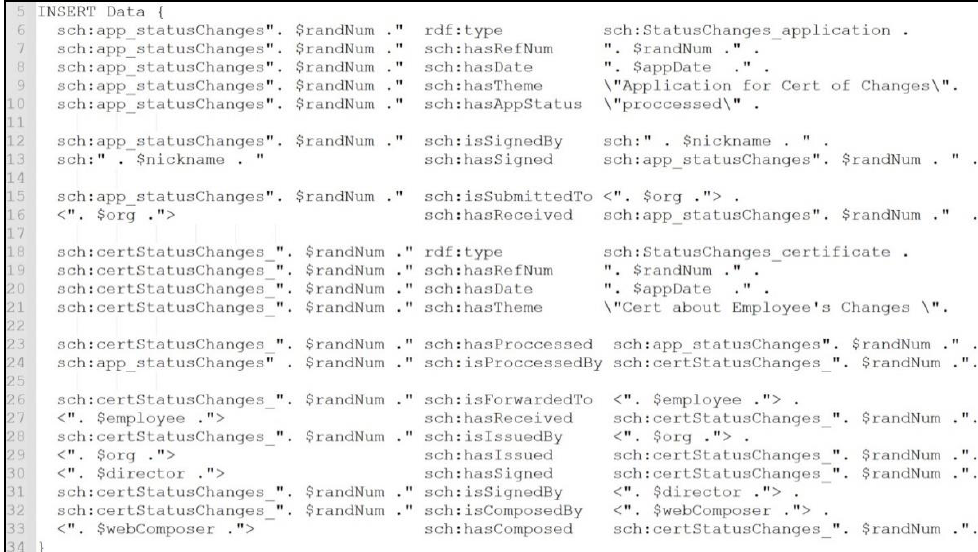
Figure 7. SPARQL query for retrieving employee’s and organization’s information.